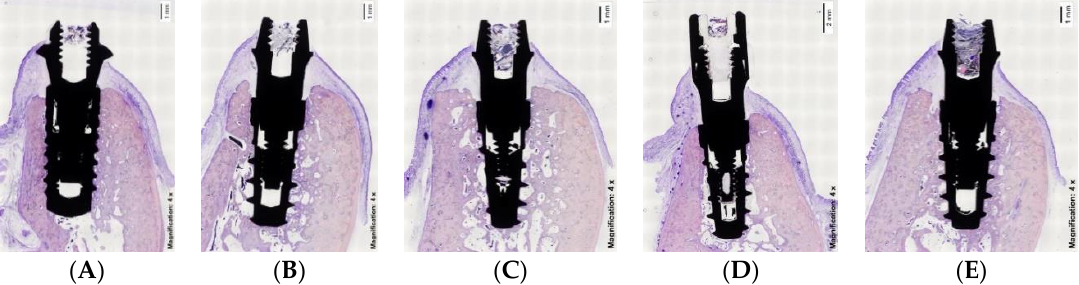
Figure 4. Histological images of delayed implants. ( A ) Straumann BL; ( B ) IPX-Std; ( C ) IPX-Half; ( D ) IPX-Full; ( E ) IPX-Control.